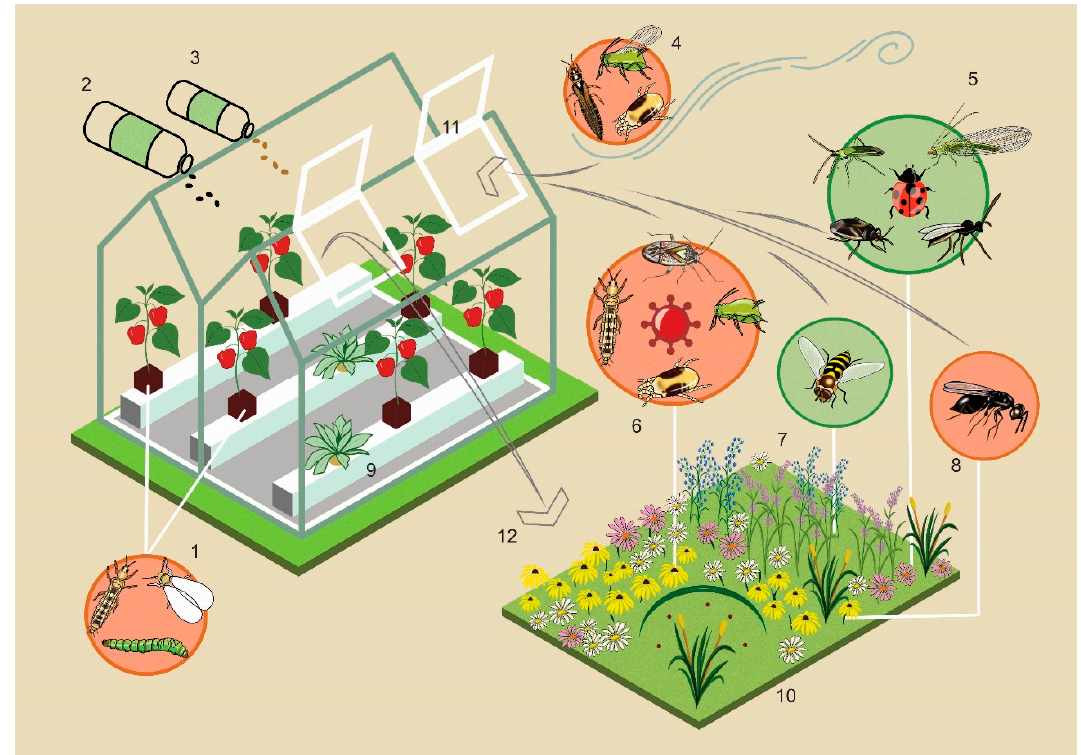
Figure 2. Schematic overview of potential pathways of pests, viruses and hyperparasitoids (orange), natural enemies and pollinators (green), and the role of plant diversity in and around greenhouses in these pathways. Numbers indicate: (1) unintentional introductions of exotic pests through plant material; (2) introduction of mass-produced natural enemies; (3) provision of food for natural enemies; (4) influx of indigenous pests through long-distance aerial dispersal; (5) indigenous natural enemies around greenhouses that control pests outside and inside greenhouses; (6) indigenous pests around greenhouses that actively migrate into greenhouses and transmit viruses in some cases; (7) indigenous syrphids that mi- grate to greenhouses and contribute to pollination and aphid control inside greenhouses; (8) hyperparasitoids that migrate to greenhouses and disrupt biological control; (9) banker plants inside greenhouses that support natural enemies; (10) diversity of plant species near greenhouses that support natural enemies by providing shelter, nectar, alternative prey, and pollen; and (11) ventilation windows as entrances for indigenous pests and natural enemies but also (12) a possible pathway for migration of greenhouse pests and natural enemies to the vegetation near greenhouses.